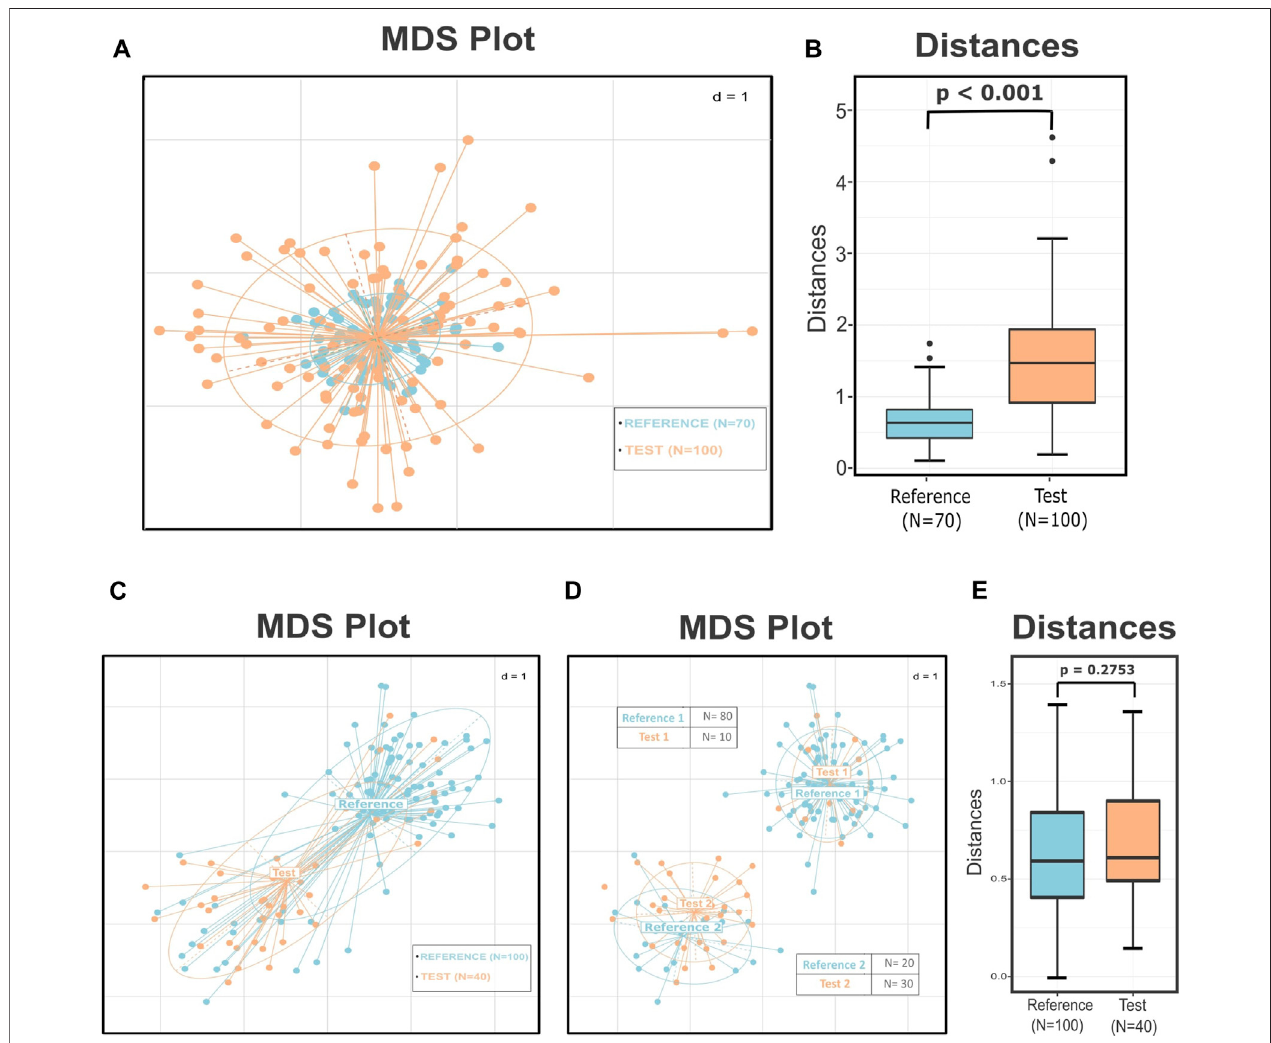
FIGURE1| Simulateddatademonstratinghowdifferentdispersionamonggroupsin fl uencestheresultsofthestatisticaltestsandhowthesubstructureswithinthe groups and the uneven sampling of these subclusters can lead to a misleading interpretation of the data. (A) MDS plot presenting two groups with the same center but according to the PERMDISP test signi fi cantly different variances ( p < 0.001). The p -value of the PERMANOVA and ANOSIM tests for these groups is 0.838 and 0.556, respectively, leading tonotrejecting the nullhypothesisthat thetwogroups aredrawn from thesame distribution. (B) Boxplots presentingthedistancesofthetest points from the center of the reference group. The p -value of the Wilcoxon rank sum test is less than 0.001, implying correctly that these two groups are signi fi cantly different. (C) MDS plot that presents two groups with similar dispersions ( p = 0.35) but seemingly different centers. The results of the PERMANOVA ( p < 0.001) and ANOSIM( p < 0.001)testsindicatethatthesetwogroupsarewell-separated. (D) MDSplotillustratingthesubgroupsderivedbythe denovo clusteringofthetwogroups. The dataset now consists of two pairs of highly related clusters with different representations in the two subgroups. (E) Boxplots presenting the distribution of the distances of every test sample from their closest reference center. According to the p -value of the Wilcoxon rank sum test ( p = 0.2753), the points of the two groups do not differ signi fi cantly in their values. The perceived difference comes from the unequal representation of the two subgroups in the fi nal dataset.